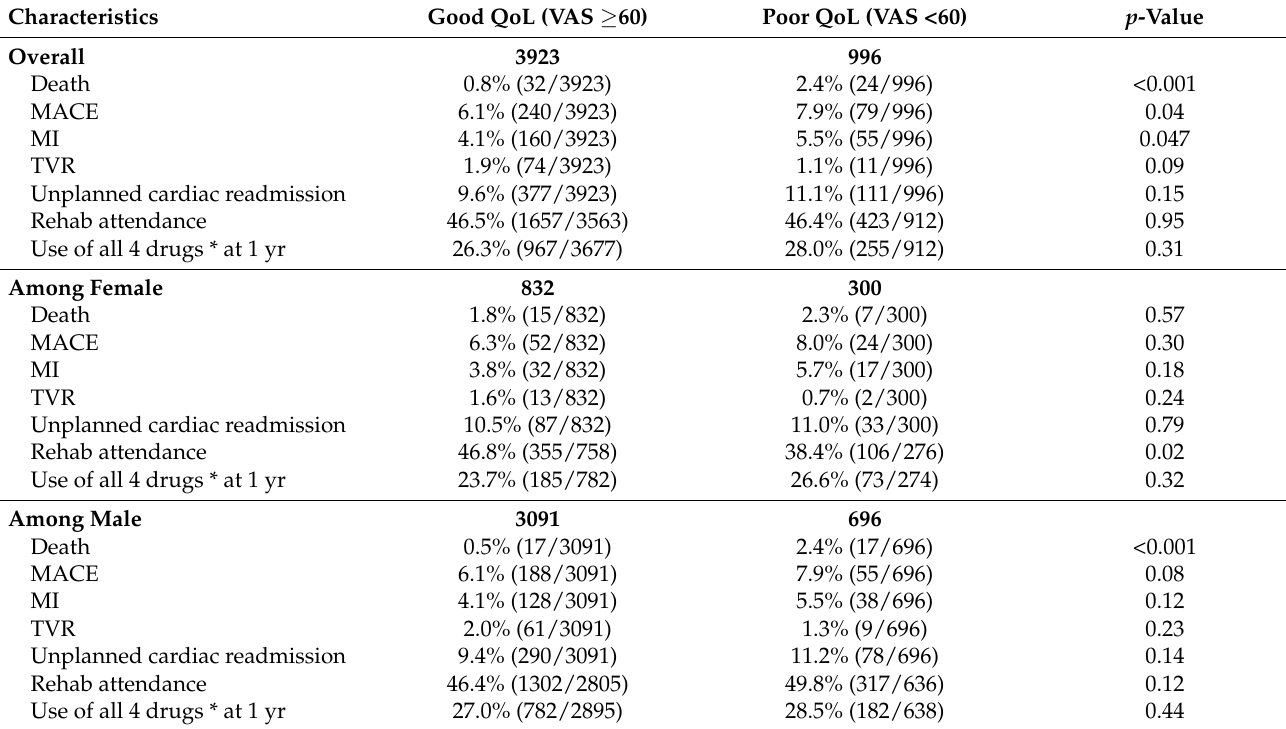
Table 5. Outcome (following discharge) of patients with completed VAS score and completed 1-year